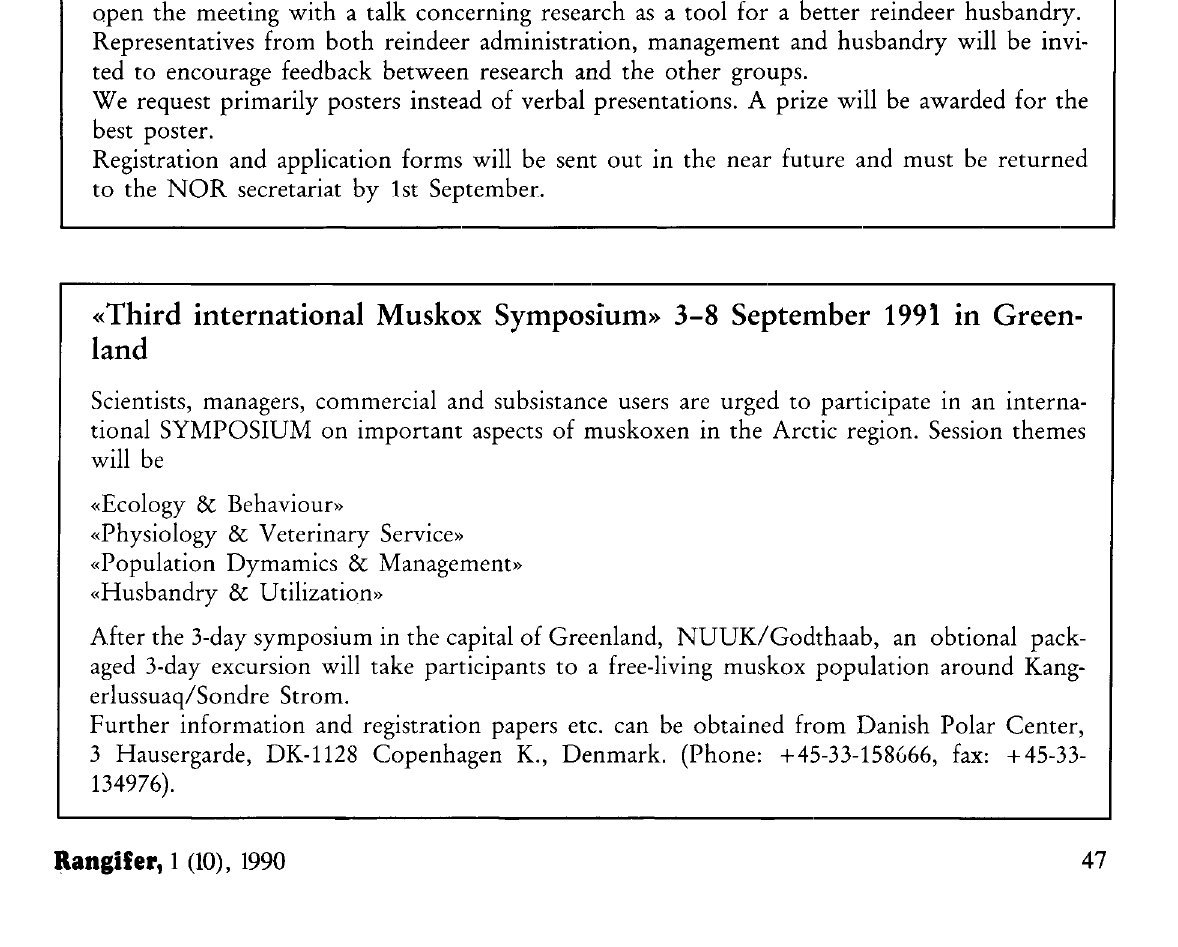
6. Nordiske Reinforskermøte. Dette blir avholdt i Tromsø i dagene 8.-10. oktober 1990. Hovedtema blir: Kjøttkvalitet og Reindrift og økologi, men som vanlig er det åpent for viten skapelige presentasjoner fra hele fagområdet rein/reindrift. Det ønskes flest mulig presenta sjoner på-postere. Premie gis til beste poster. Formann i Reindriftsstyret i Norge, fylkesmann Erling Nordvik, vil holde innledningsfore drag om forskning som hjelpemiddel til en bedre reindrift. Det tas sikte på å innby representanter for administrasjon, rådgivning og reinnæring for å oppmuntre til «feedback» mellom disse